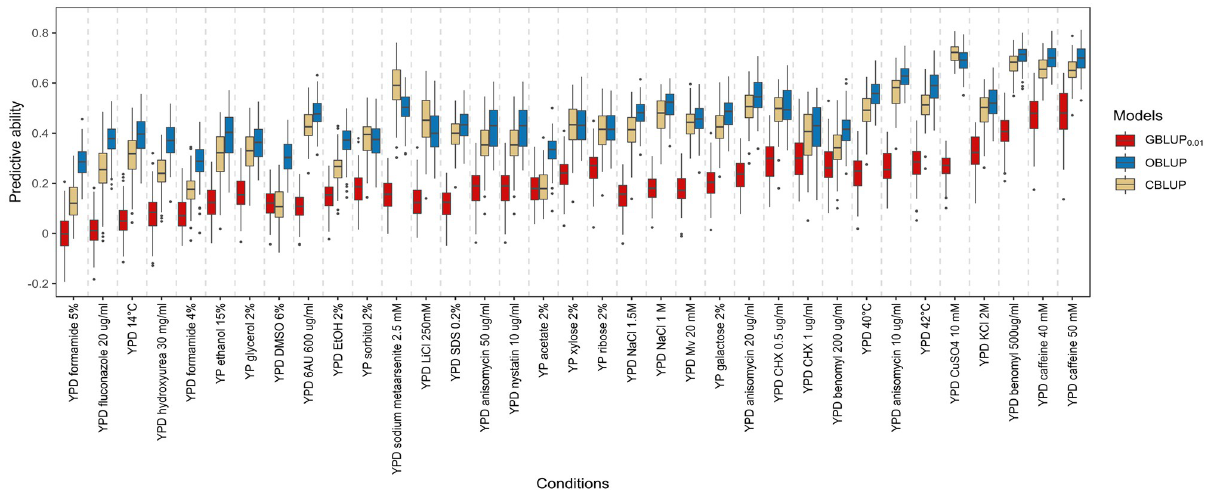
Fig 4. Predictive abilities of three models across 35 traits. GBLUP 0.01 using all common SNPs, OBLUP using pan-genomic open reading frames, and CBLUP using copy numbers of pan-genomic open reading frames.